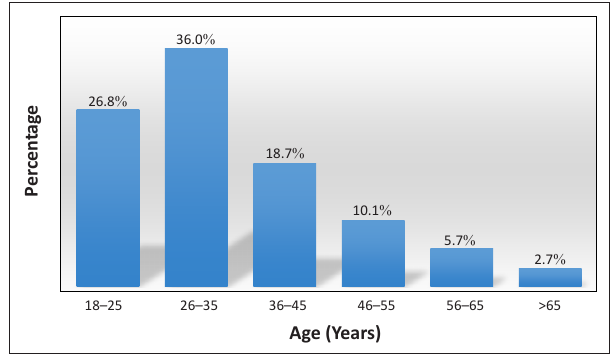
FIGURE 2: Respondents’ age profile.